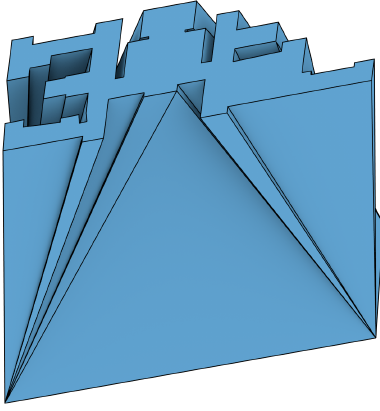
Figure 2: Two LODs of a building footprint are stored as a sin- gle polyhedron. Note that the correspondences between vertices, edges and faces between the LODs are clearly indicated by the vertical edges and faces.